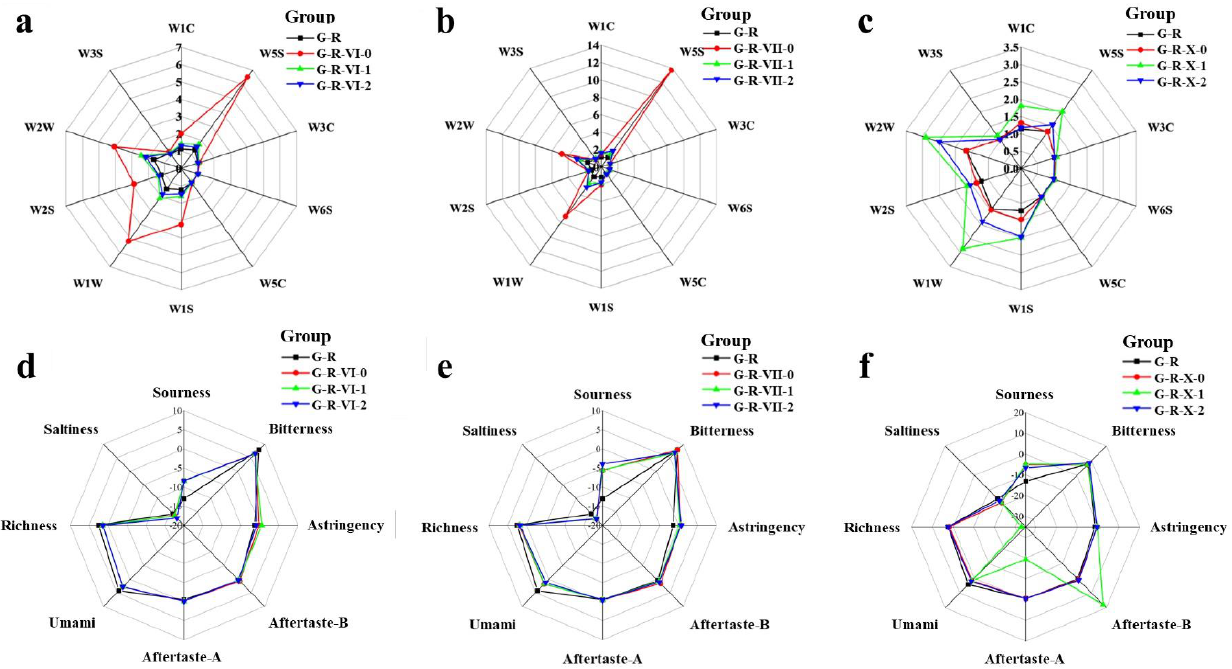
Figure 2. E-nose and E-tongue analysis of MRPs produced by MR systems with different aliphatic aldehydes: ( a – c ) E-nose and ( d – f ) E-tongue analysis of the ( a , d ) control (G-R) and G-R-VI groups (G-R-VI-0, G-R-VI-1, and G-R-VI-2), ( b , e ) G-R and G-R-VII groups (G-R-VII-0, G-R-VII-1, and G-R-VII-2), and ( c , f ) G-R and G-R-X groups (G-R-X-0, G-R-X-1, and G-R-X-2).